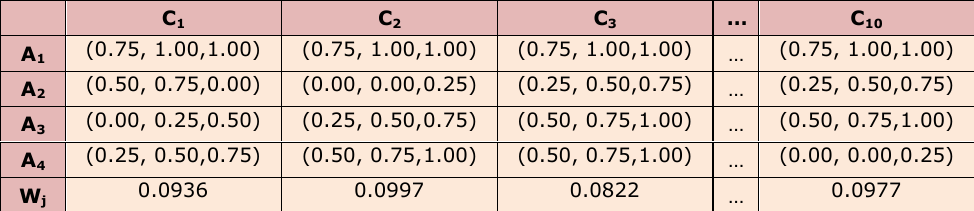
Table 7. Thenormalized decision matrix